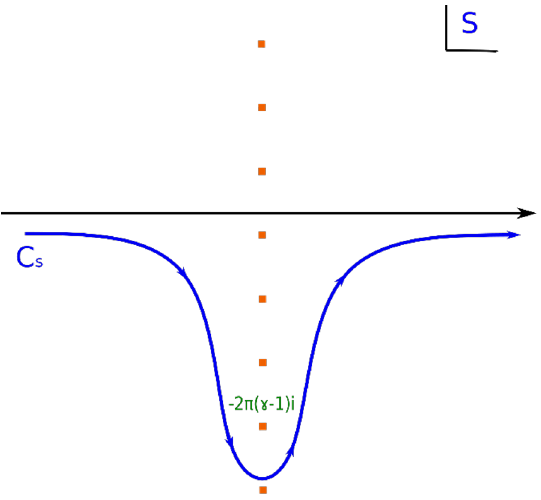
= 2 (cid:25)i ( k (cid:0) (cid:13) ) 2